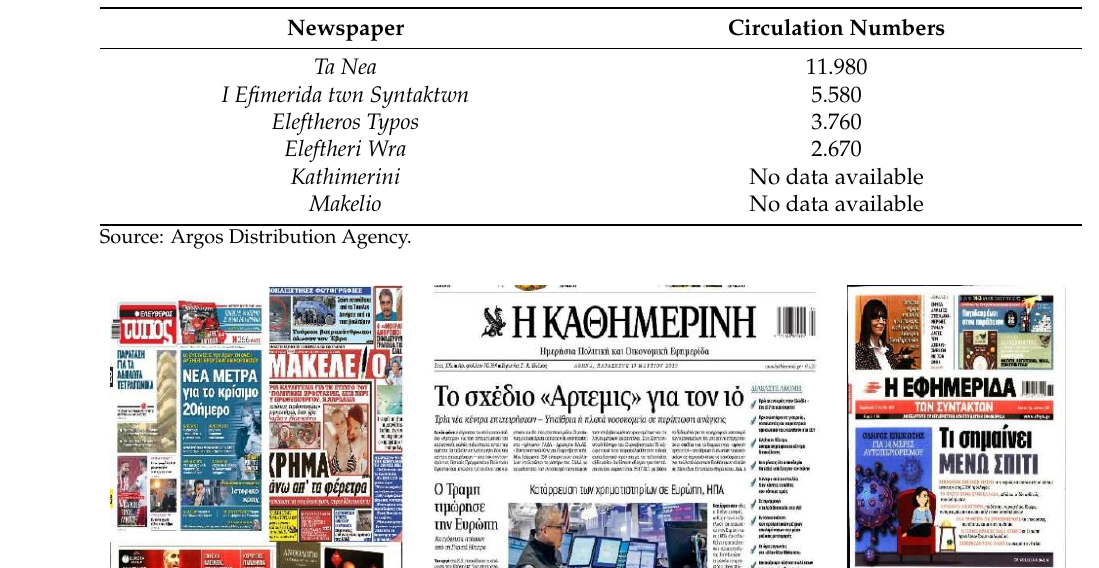
Table 2. Newspaper circulation (13 March 2020).